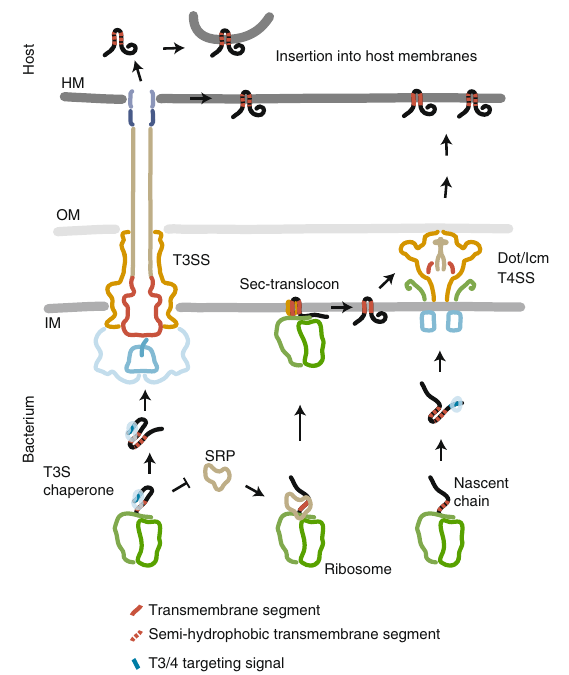
Fig. 6 Model of targeting discrimination of secreted transmembrane proteins The semi-hydrophobic nature of most TMS of type III-secreted and type IVB-secreted transmembrane proteins prevents recruitment of SRP and erroneous targeting to the Sec-translocon. In addition, speci fi c T3SS chaperones bind TMS of type III-secreted transmembrane proteins and thus shield these segments from wrong targeting factors and aggregation. T4BSS can also accept strongly hydrophobic substrates from within the bacterial inner membrane. HM host membrane, IM inner membrane, OM outer